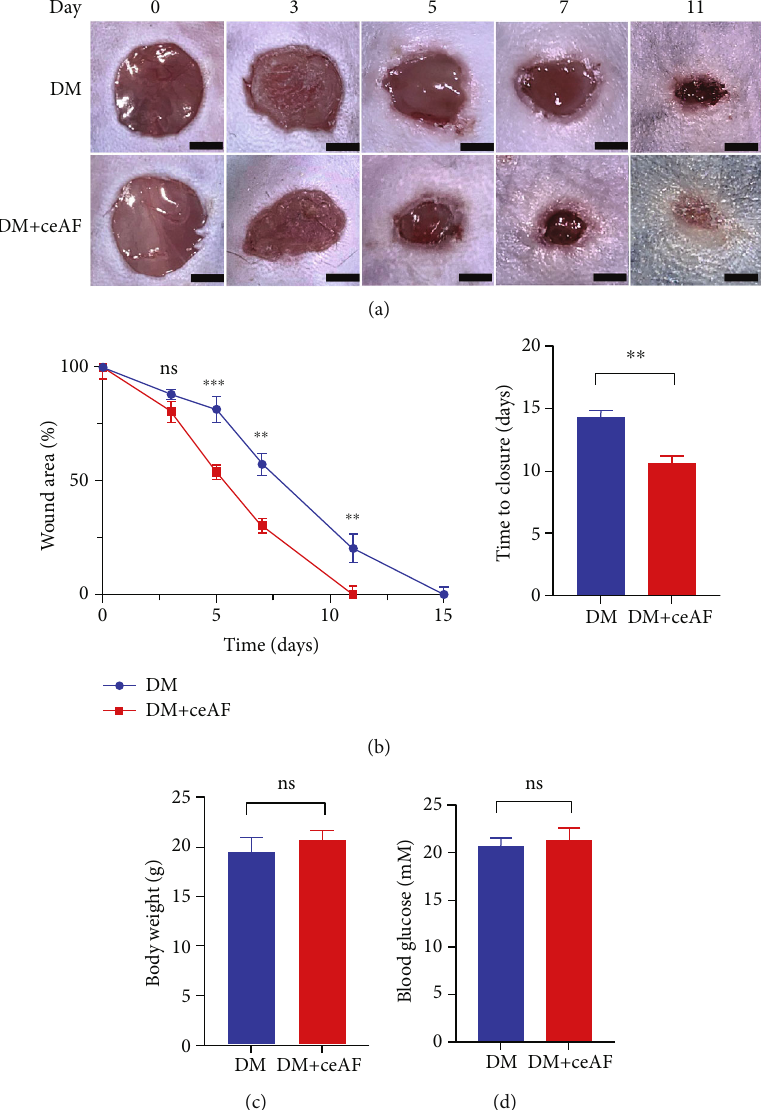
Figure 3: Treatment with ceAF ameliorates wound healing in STZ-induced diabetic mice. (a) Data for wound changes were recorded daily from day 1 to day 11. (b) Statistical graph representation of wound area and time to closure. (c) The measured body weight of the experimental mice on day 11. (d) The measured blood glucose of the experimental mice on day 11. Scale bar: 3 μ m. n = 6 , ns: no statistical signi fi cance, ∗∗ P < 0 : 01 , ∗∗∗ P < 0 : 001